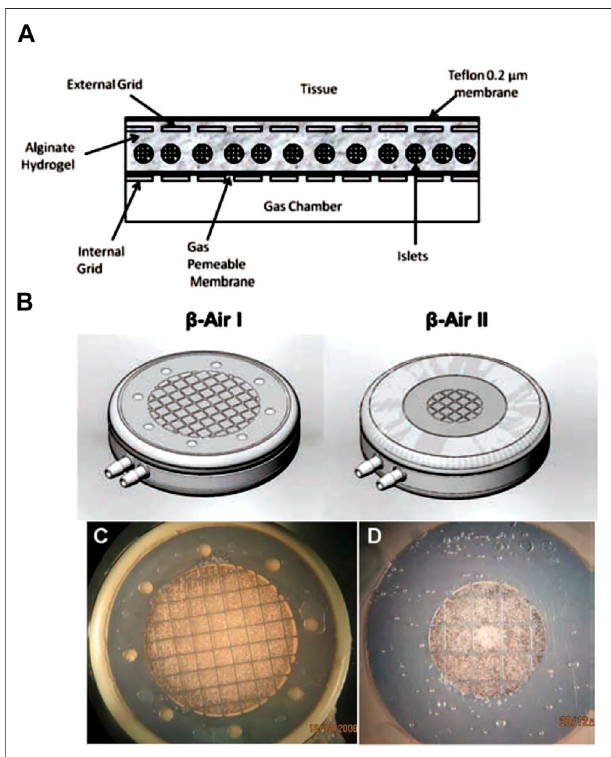
FIGURE 9 | Schematic view of the β Air I and II implantable bioarti fi cial pancreas devices: (A) cross-section and (B) external view. The β -Air I (C) and β -Air II (D) modules seeded by islets before implantation (Barkai et al.,